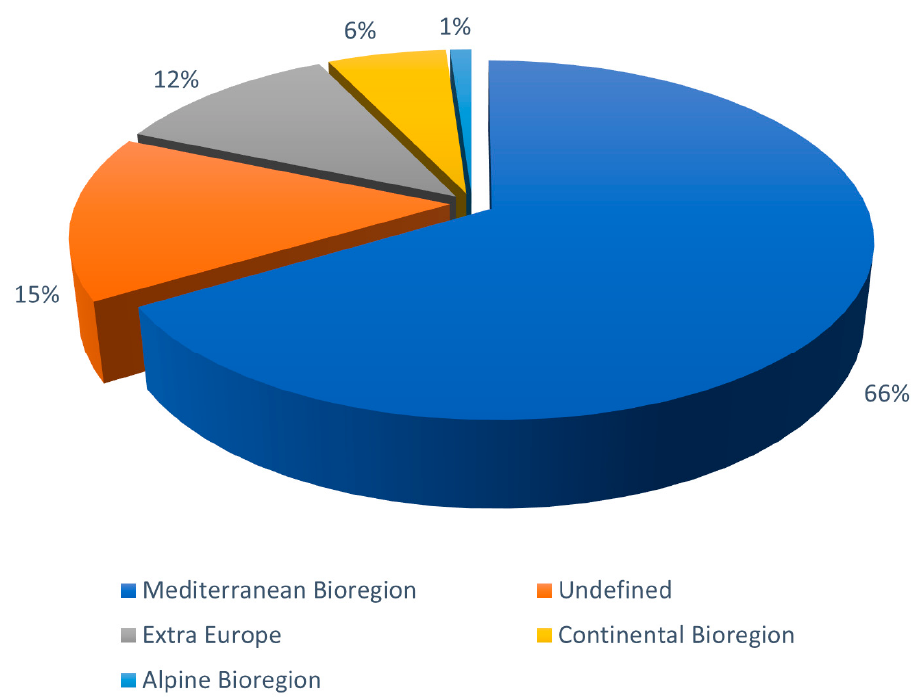
Figure 3. Percentage of all “Extreme rainfall events” articles grouped by their geographical distribution.